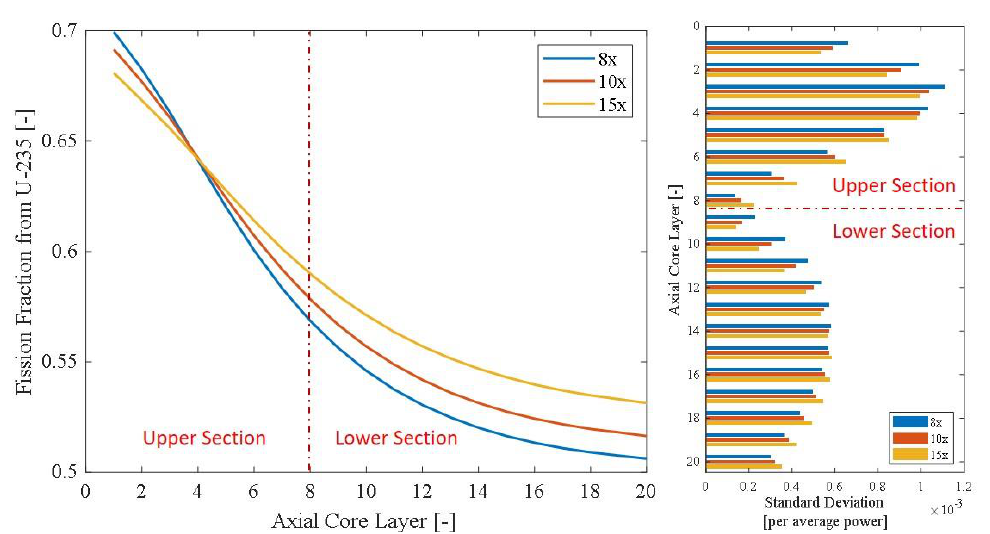
Figure 8. U-235 fission fraction alongside Channel I (left) and standard deviation of regional relative power in Channel I (right). This fraction accounts for U-235 fission among all fissile fission, including U-233, U-235, Pu-239 and Pu-241. Upper section stands for region 1 to region 8 and lower section stands for region 9 to region